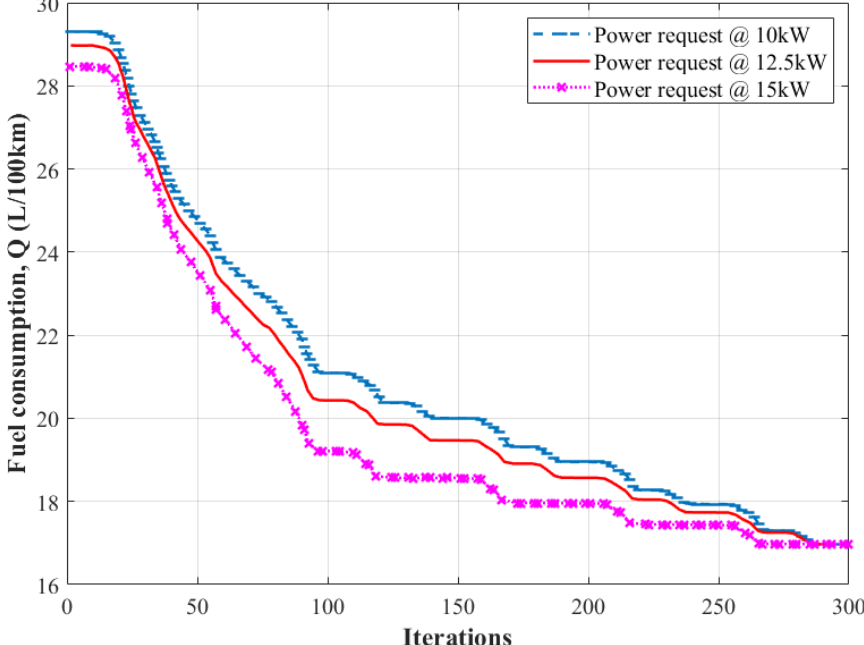
Figure 6. The iterative process of optimized fuel